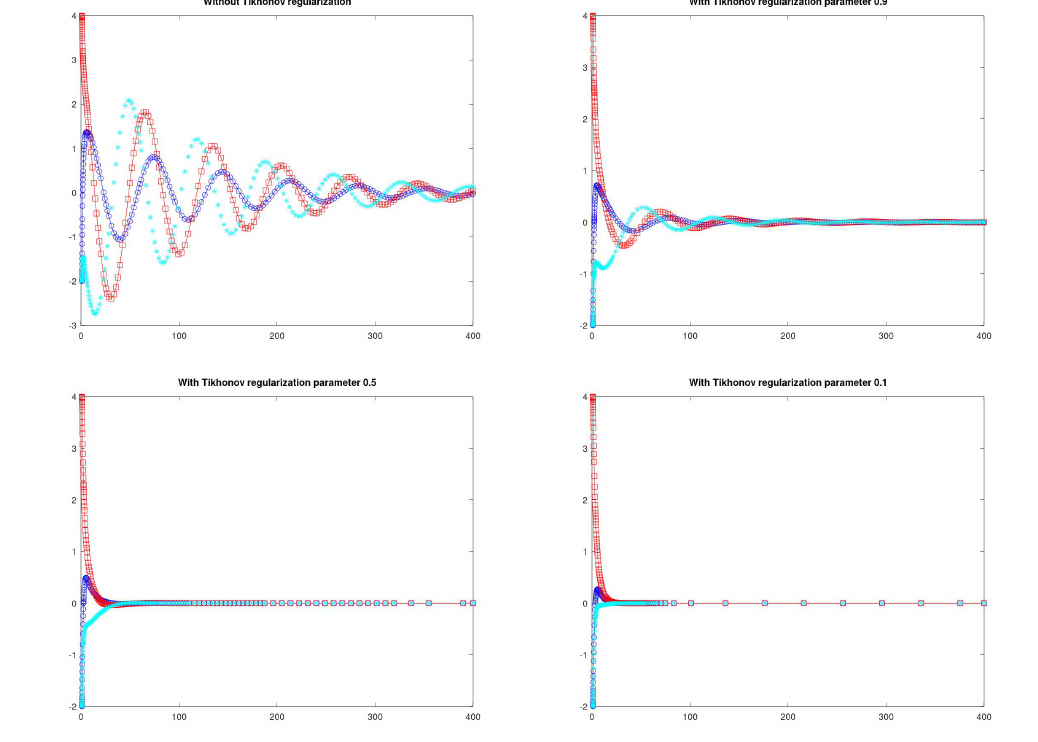
Fig. 7: Trajectories of ( FBFR ) for regularization parameters β ∈ { 0, 0.1, 0.5, 0.9 } and γ =